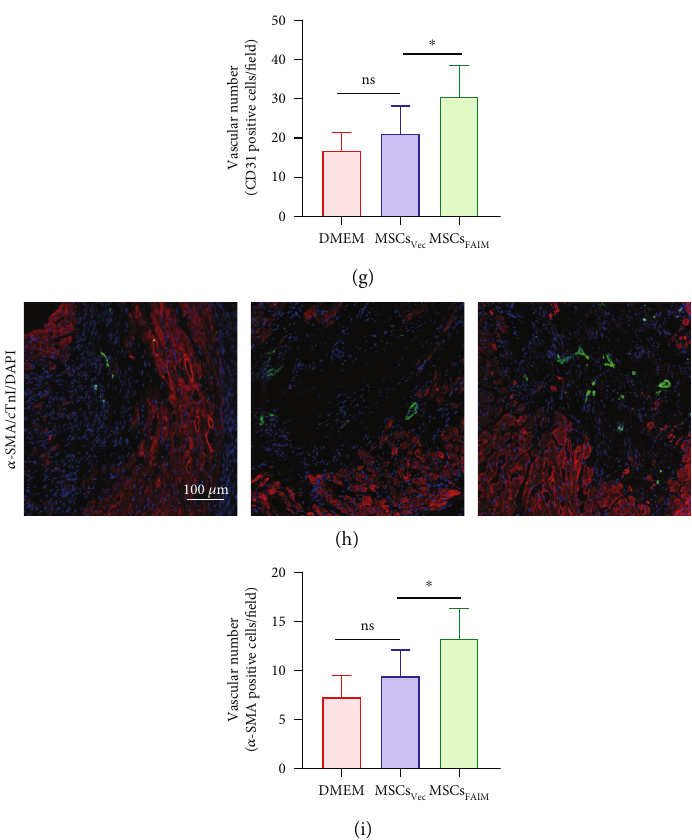
Figure 2: MSCs improved cardiac function and reduced infarction size. (a) Representative echocardiographic images of the left FAIM ventricle in M-mode on days 3, 7, 14, and 28 after LAD ligation followed by MSCs engraftment. (b) Ejection fraction (EF) and (c) groups, and n = 8 for the fractional shortening (FS) were quanti fi ed ( n = 6 for the sham group, n = 7 for the DMEM and MSCs Vec group). (d) Representative Sirius Red staining of ischemic hearts 28 days after MI. (e) Scar size was calculated as the sum of MSCs FAIM groups and the ratio of the endocardial plus epicardial scar length relative to the total circumference ( n = 7 for the DMEM and MSCs Vec n = 8 for the MSCs group). (f – g) Representative images showing CD31 immuno fl uorescence staining in the peri-ischemic area 28 FAIM days after MI. CD31 appears in green, cardiac troponin I (cTnI) in red, and nuclei in blue ( scalebar = 100 μ m ). Quantitative results are groups and n = 8 for the MSCs group). (h – i) Representative images showing shown on the right ( n = 7 for the DMEM and MSCs Vec FAIM α -SMA IF staining. α -SMA appears in green; scale bar = 100 μ m . Quantitative results are shown on the right ( n = 7 for the DMEM and groups and n = 8 for the MSCs group). Vessels in the peri-ischemic area were counted in 5 randomly chosen fi elds. The MSCs Vec FAIM data are shown as the mean ± SD . Ns indicates not signi fi cant; ∗ denotes P < 0 : 05